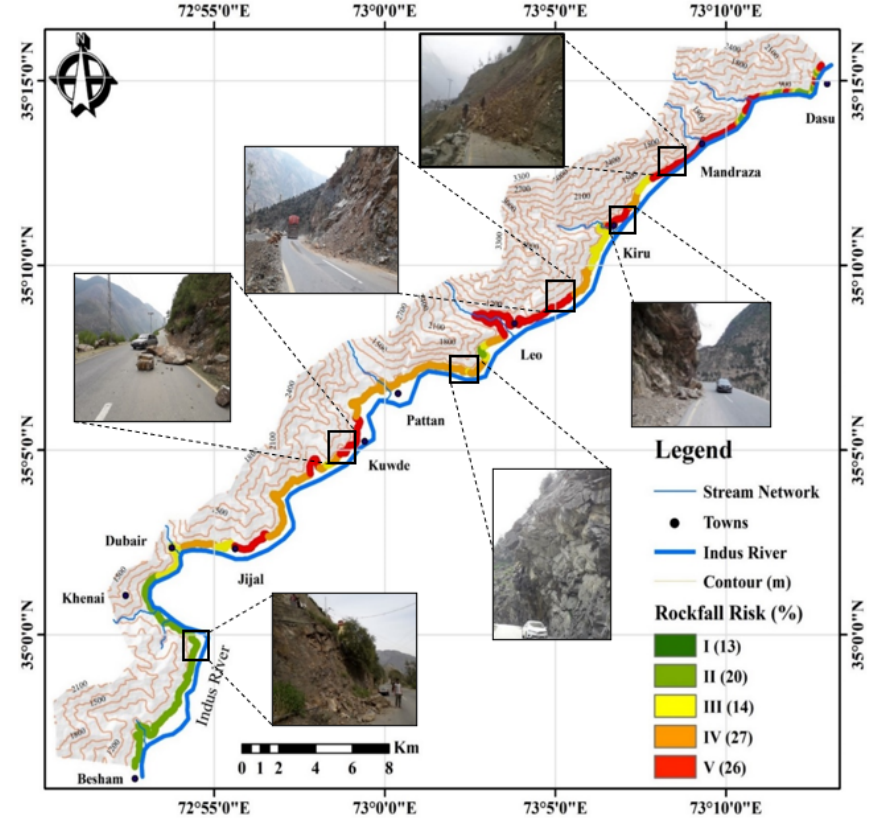
Figure 9. Rockfall Risk map along the Karakoram highway from Besham to Dasu.